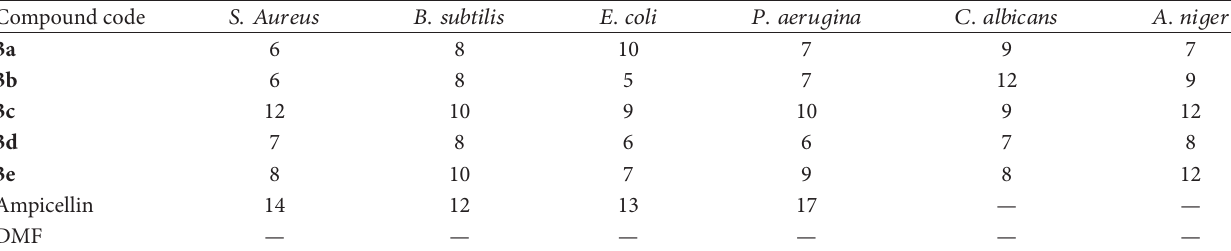
T 6: Zone of inhibition produced by each